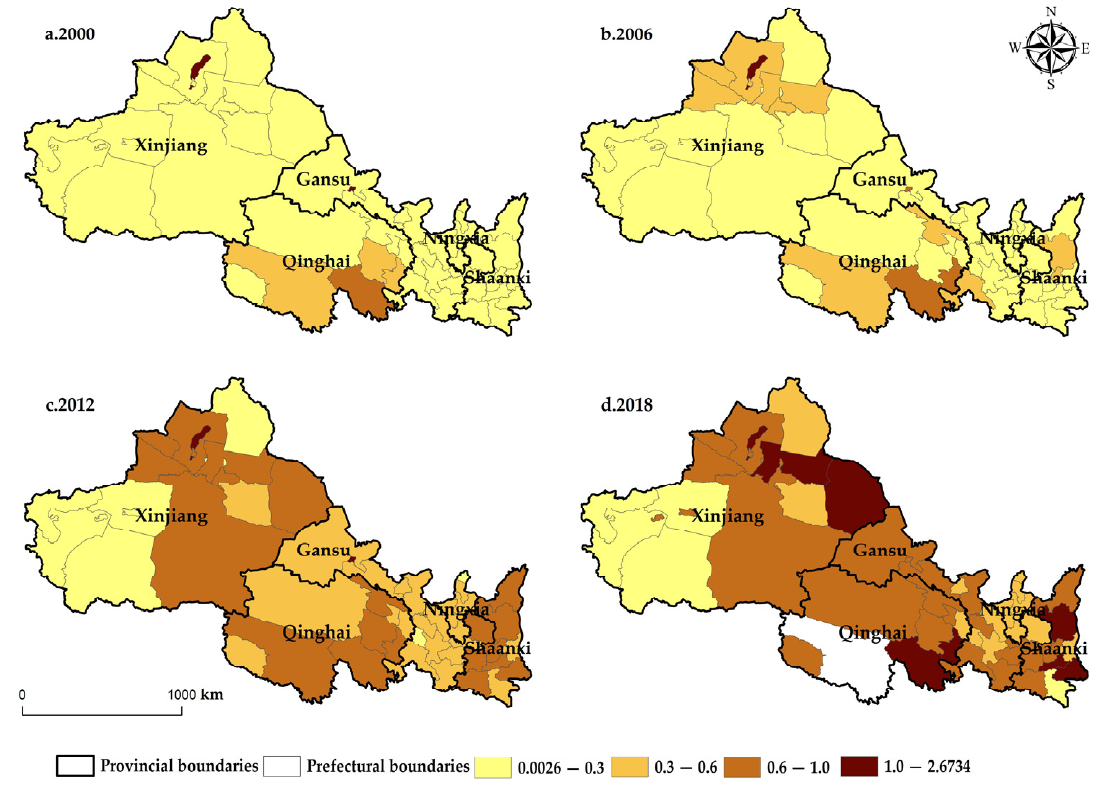
Figure 3. Spatial distribution of AWUE in Northwest China.